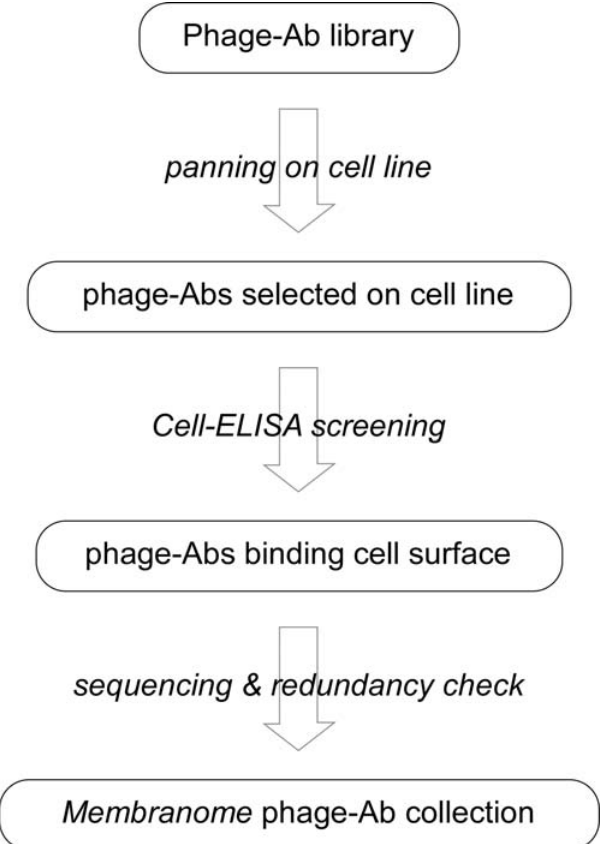
Figure 1. Strategy adopted to generate the 10k Membranome phage-Ab